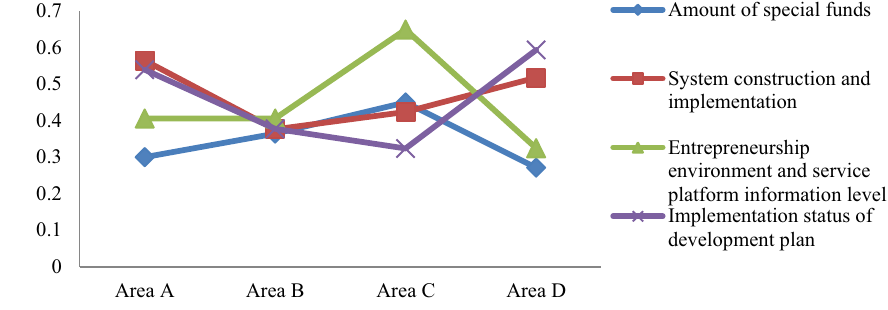
Fig. 2 Changes of the indicators under organizational guarantee element vs.